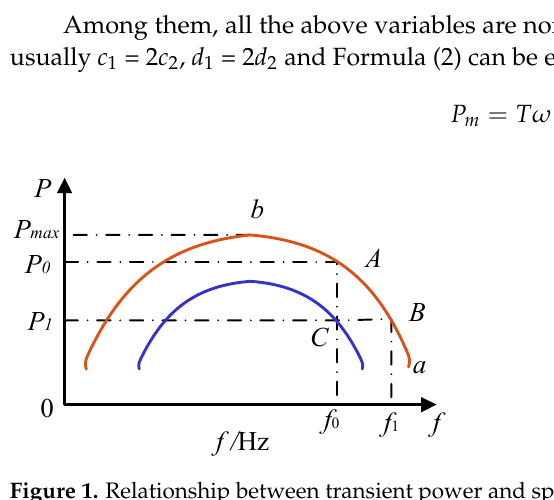
Figure 1. Relationship between transient power and